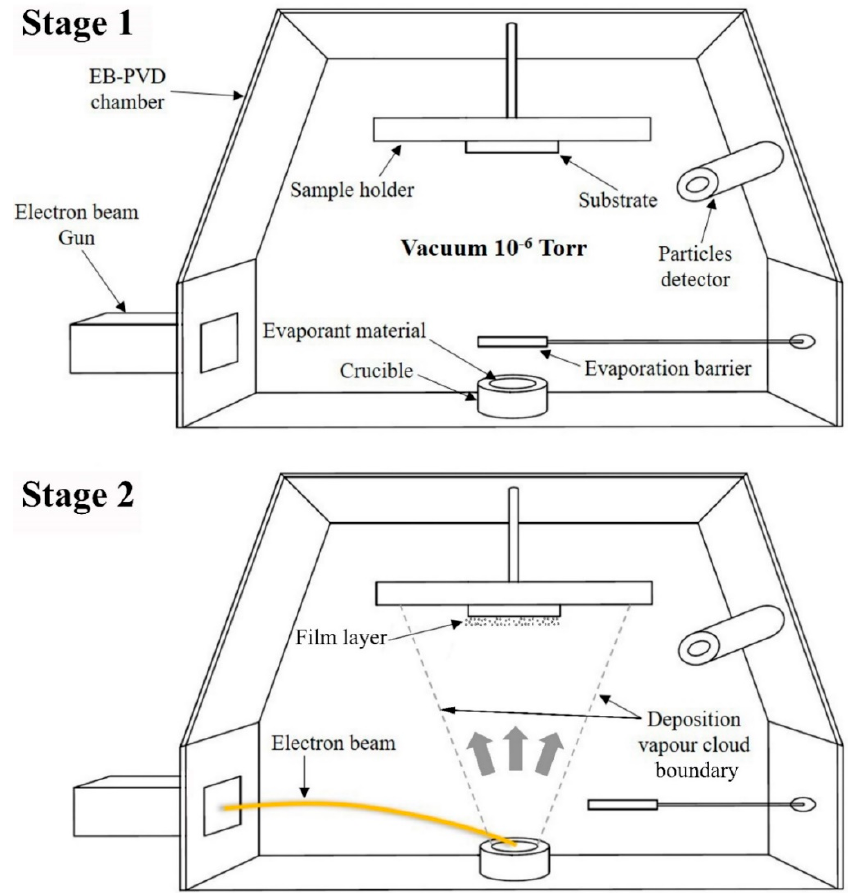
Figure 1. Electron beam physical vapour deposition process, where (Stage 1) shows the schematic illustration of the device configuration, and (Stage 2) demonstrates the source evaporation and film formation process.